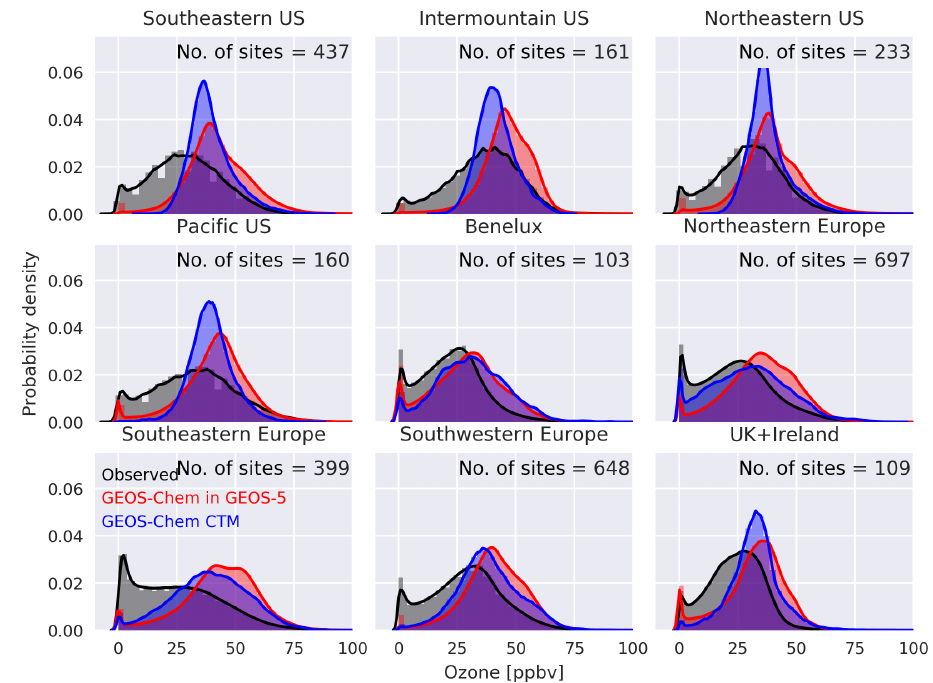
Figure A5. Probability distribution of ozone concentrations (ppbv; all 24h data) for 2013–2014 at surface sites in the US and Europe.